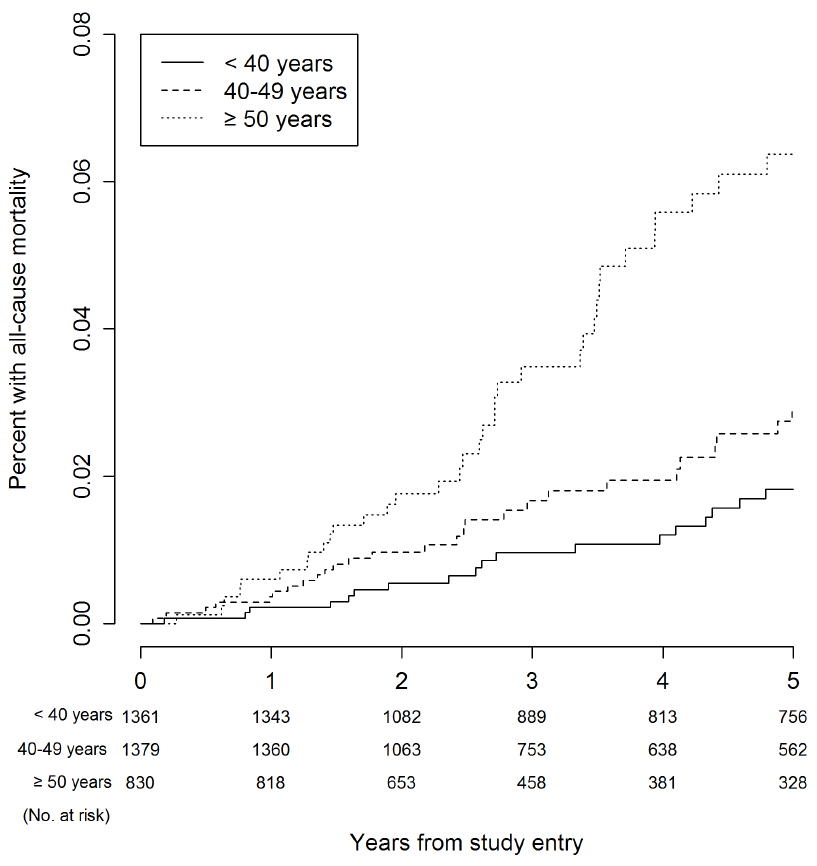
Figure 2. Cumulative probability of death by age group.